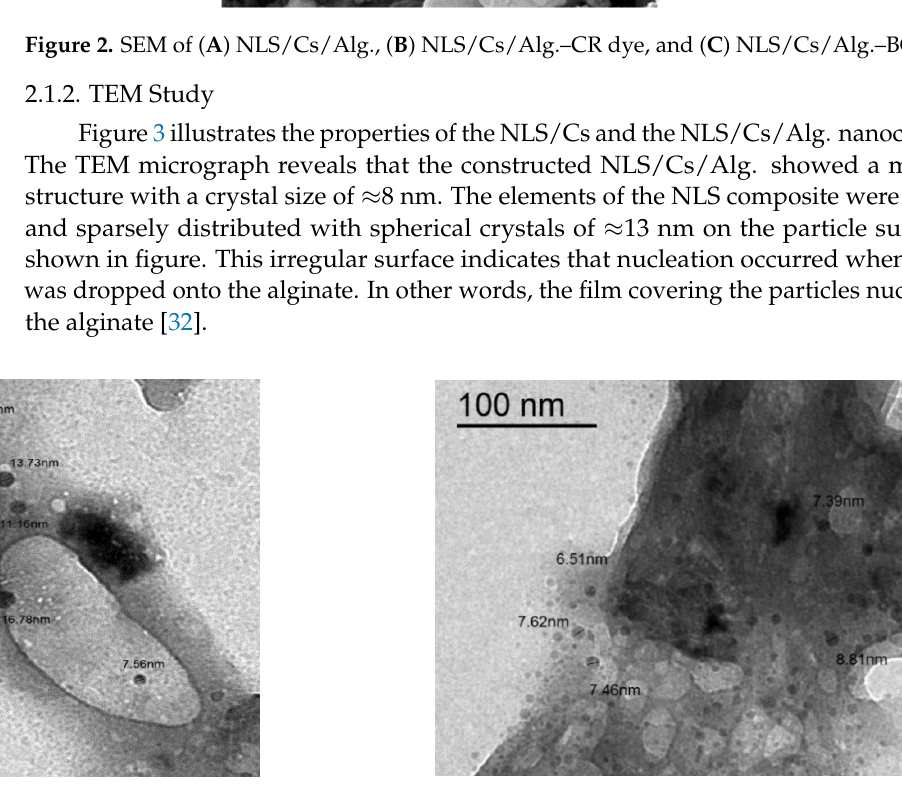
Figure 3. TEM micrographs of the synthesized NLS/Cs/Alg. composite.